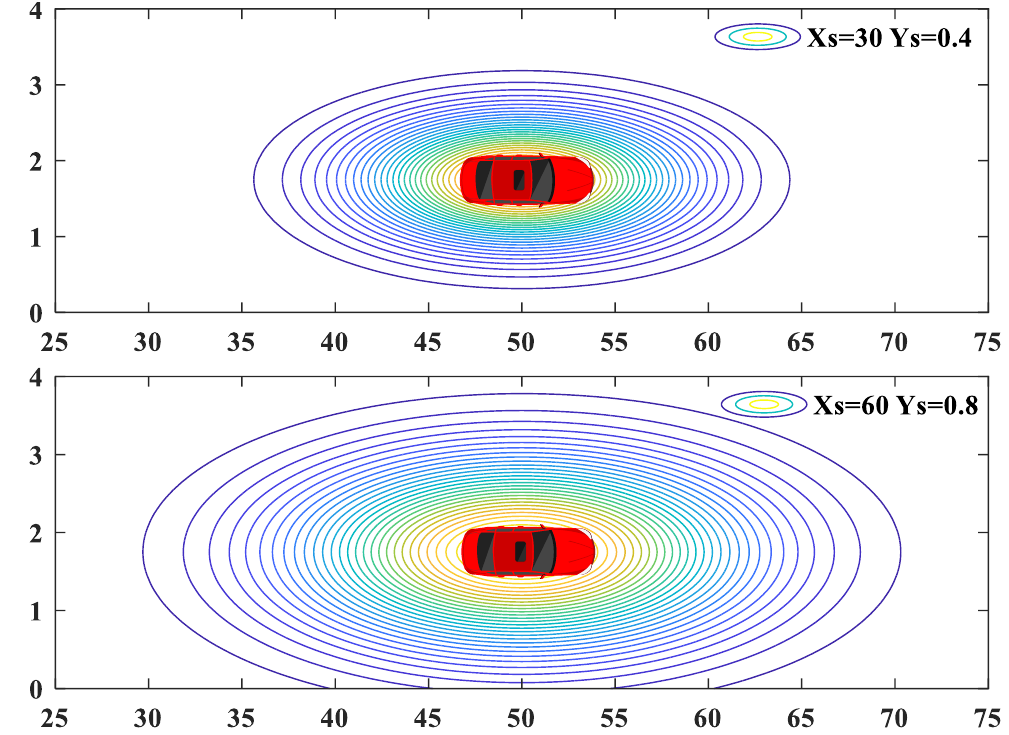
Figure 3. Potential fields with different longitudinal and lateral safe